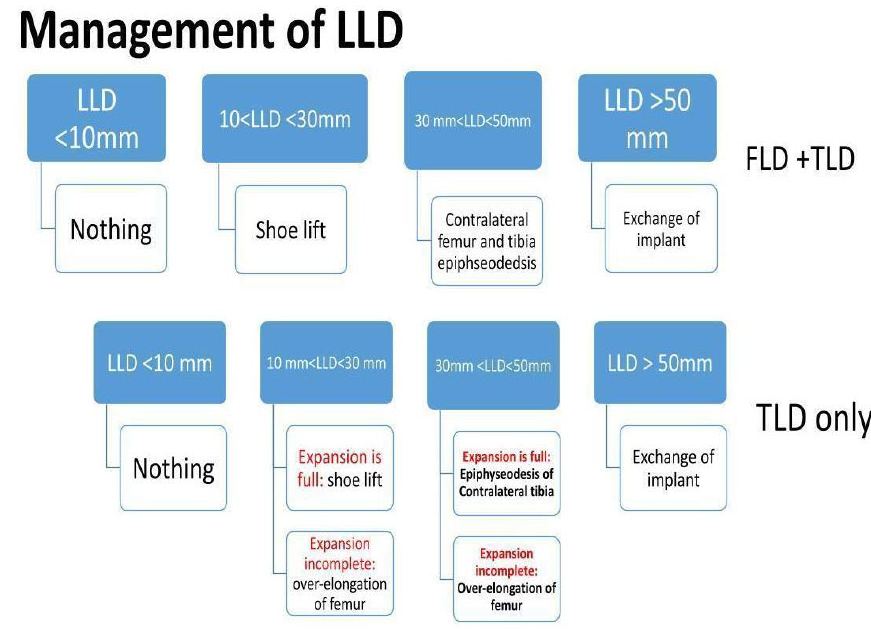
Figure 8. Management of